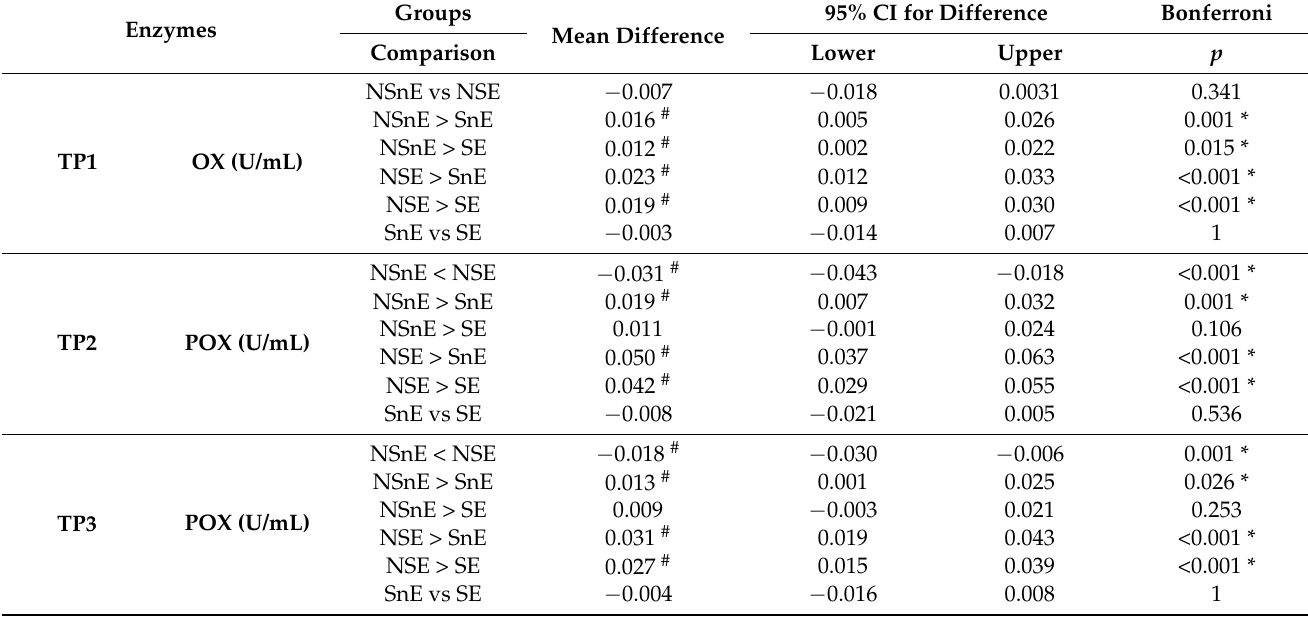
Table 3. Changes in POX, CAT, and SOD enzyme activities among groups at three time points. Enzymes